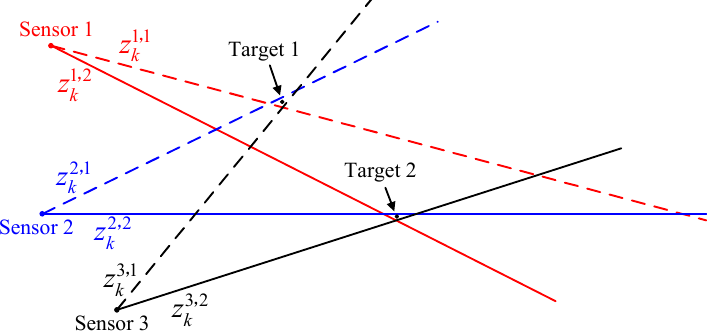
Figure 3. A scenario with 3 passive sensors and 2